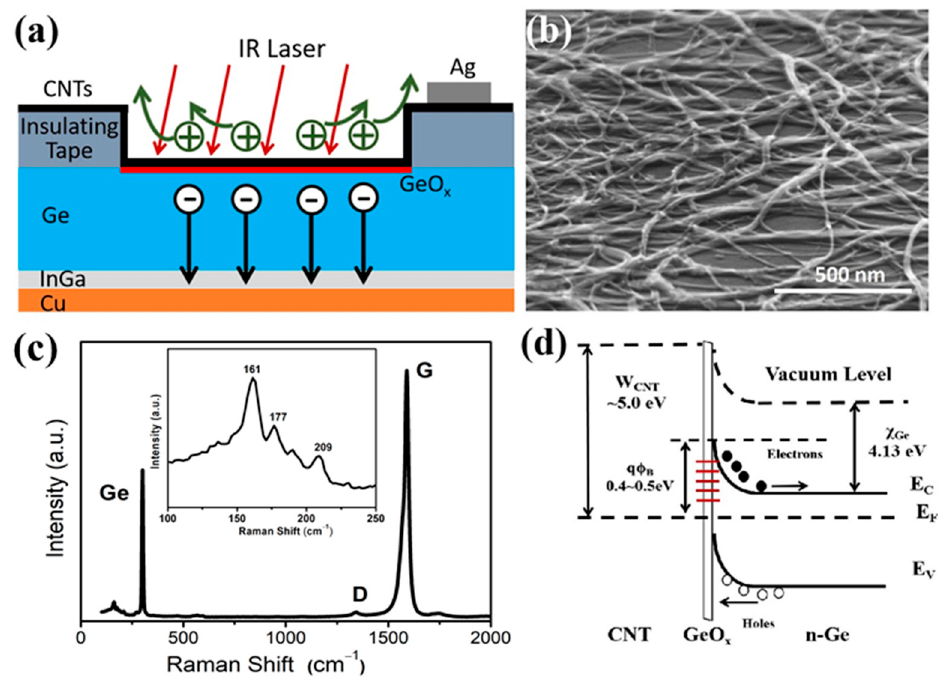
Figure 1. The SWCNT-Ge heterojunction photodetector. ( a ) A schematic illustration of the SWCNT-Ge photodetector; ( b ) SEM image of the SWCNT-Ge interface; ( c ) Raman spectra of the SWCNT-Ge photodetector; ( d ) Energy band diagram of the SWCNT-Ge photodetector.